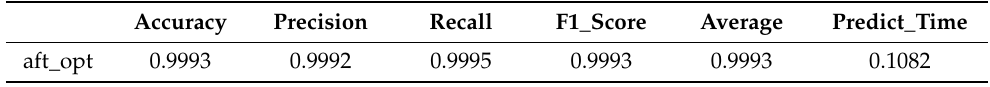
Table 10. RF optimized performance